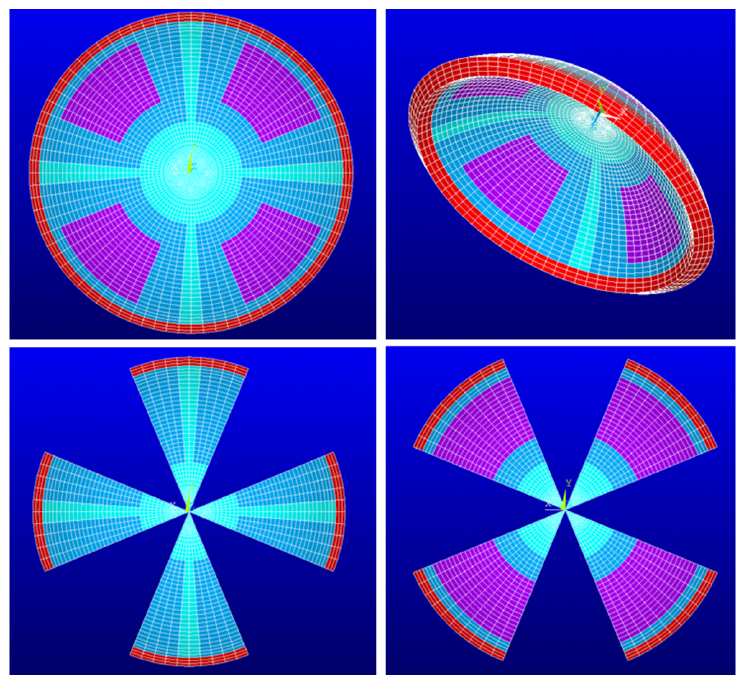
Figure 1. Definition of material zones in corneal finite element model (example with Navarro Geometry). Central, Nasal-Temporal, Superior-Inferior zones (Light Blue), Oblique Zones (Purple), Limbus (Red), and Transition zones (Blue).